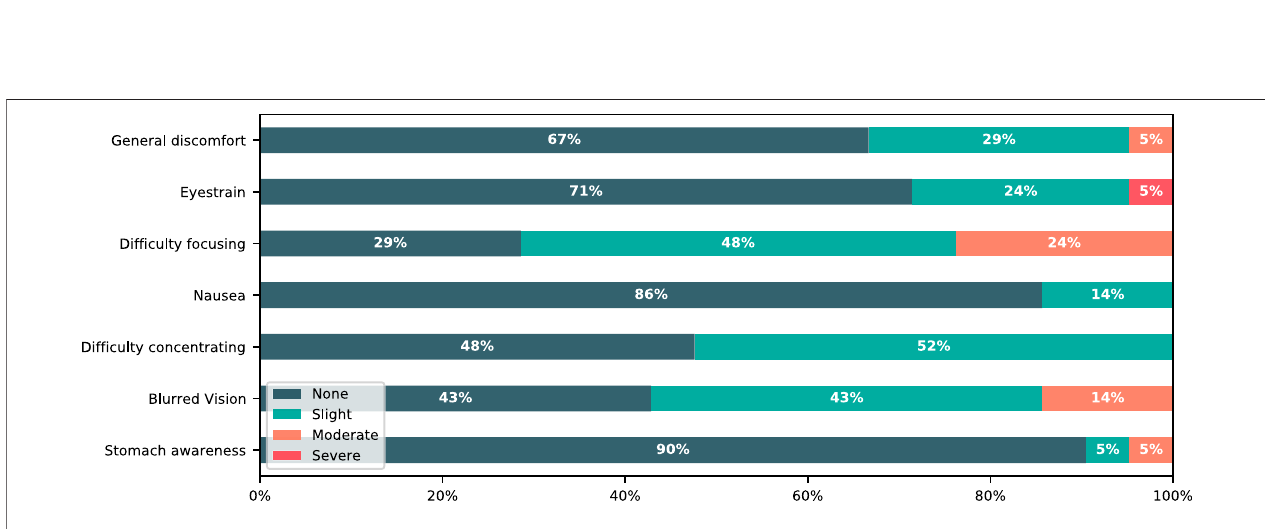
FIGURE6| ReportedresultsofthesubsetoftheSimulatorSicknessQuestionnaire(SSQ)usedtomeasuretheperceivedqualityofexperienceduringVRexposure. The stacked bar graphs show the percentage of participants reporting each question on a 4-point Likert scale.